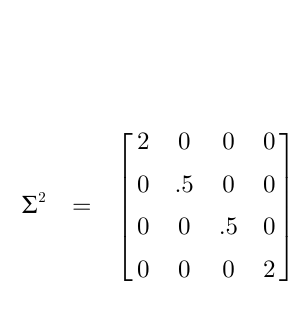
Fig 3. Three vague Normal priors used to compute Bayesian logistic regression. Top: Prior distribution used for the intercept parameter β 0 (Eq 12), which represents persons with no prior relationship and instrumental motivation ( N ( − 1, 2)). Middle: Prior distribution used for parameters β 1,2 , which represents the additional effect of persons with either a prior relationship OR an expressive motivation over the intercept value ( N (0.1, 0.5)). Bottom: Prior distribution chosen to represent β 3 , the additional effect of both having a prior relationship and expressive motivation ( N (1.1, 2)). Grey areas represent regions allowed in the prior that are the opposite of our